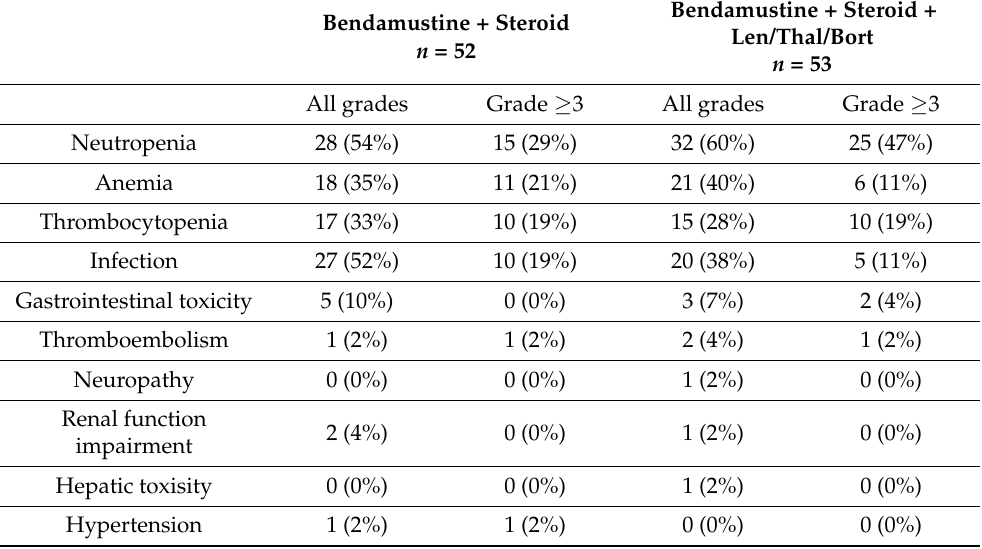
Table 3. Adverse events during bendamustine-based therapies. All differences in toxicity occurrence between study groups were not statistically significant ( p >